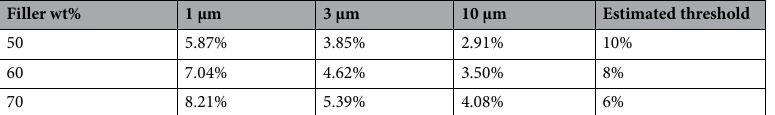
Table 4. Percentage of thiourethane (%) in each TU-Sil resin composite group considering the filler load and the variation in filler surface coverage obtained from the TGA results and the estimated threshold based on previous literature 5 . The data show that the replacement of 20 wt% of the organic matrix by thiourethane oligomer is the optimized concentration in order to decrease the polymerization stress without compromising the elastic modulus.